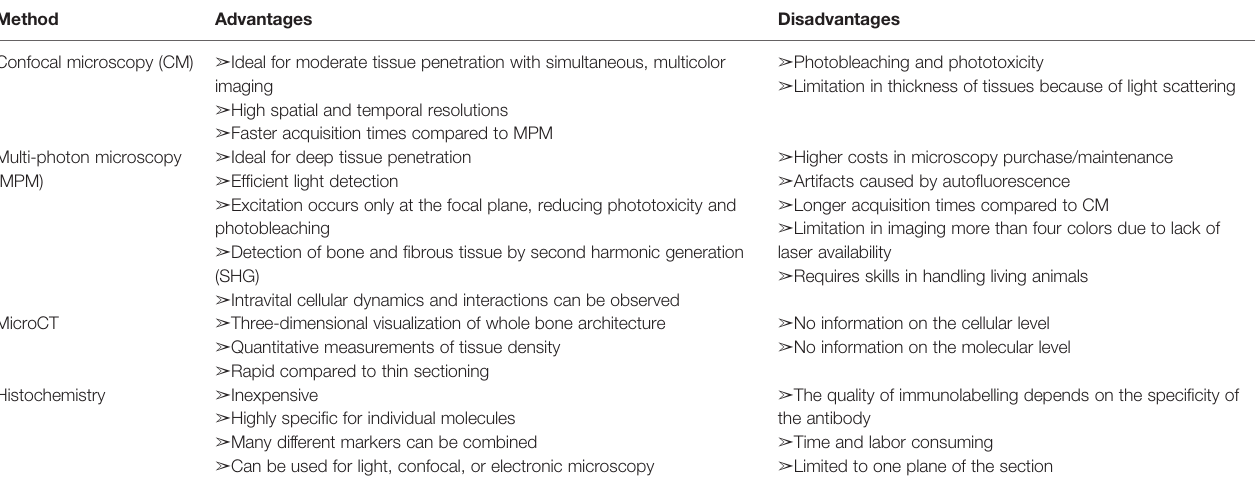
TABLE 1 | Comparison of different modalities used for bone and joint